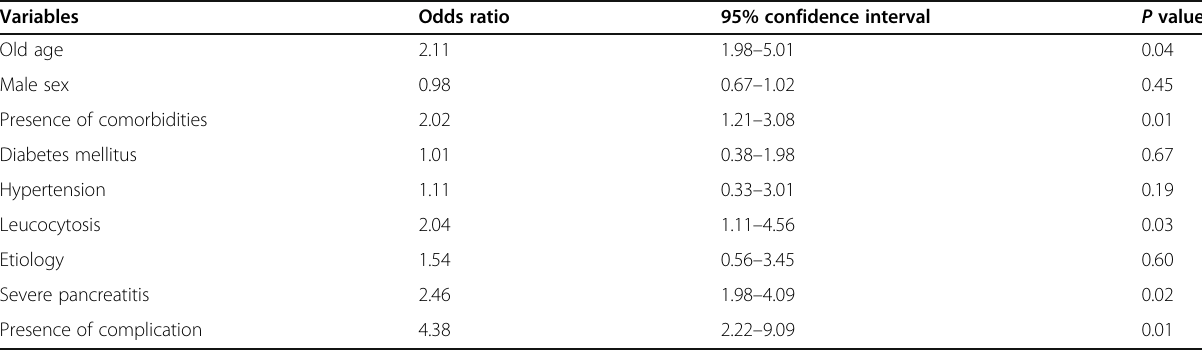
Table 5 Predictors for mortality in the current study